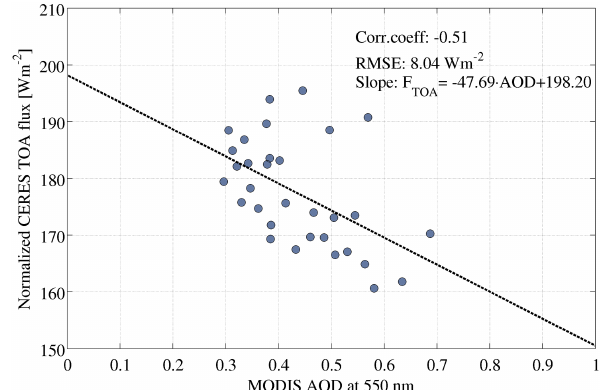
Figure 14. An example of a linear regression that resulted in neg- ative correlation between normalized TOA fluxes and AODs, and hence a warming effect at TOA. In this grid cell (33.0 ◦ N, 116.5 ◦ E) the MODIS black-sky SW albedo was 0.14. Due to the relatively dark surface, a warming effect was not expected over this